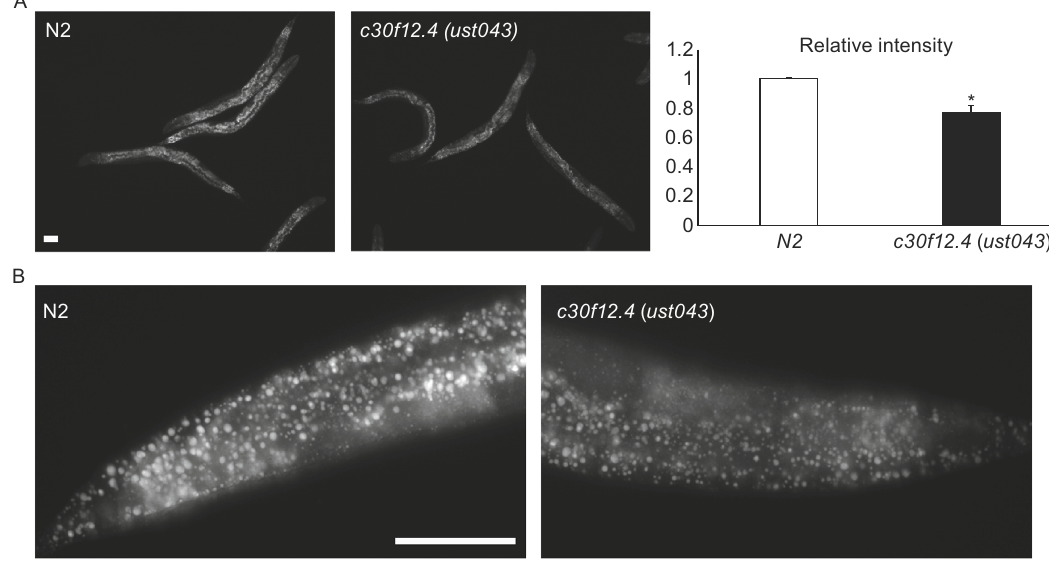
Figure 4. Loss of c30f12 .4 altered fat storage in C. elegans . Late L4 stage worms were fi xed with 40% isopropanol and stained with Nile Red. Images were captured using identical settings and exposure time for each image. Loss of c30f12.4 lead to decreased fat storage (A) and smaller lipid droplets (B). * P < 0.05, t -test. Scale bar = 50 μ